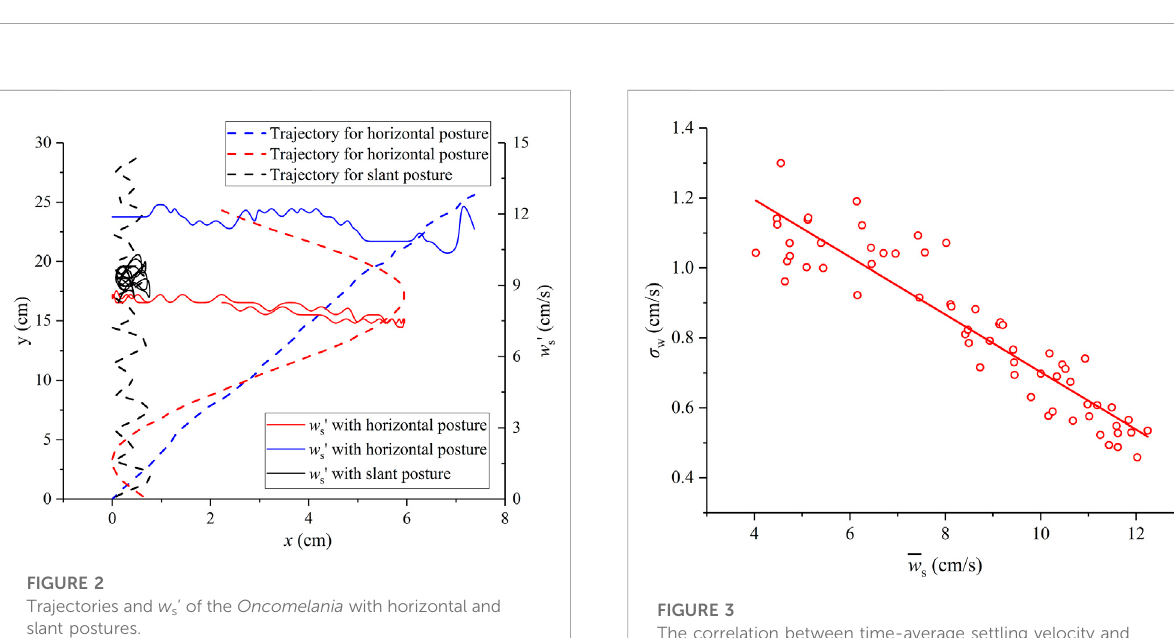
FIGURE 1 Schematic diagram of the experimental set-up and settling trajectory of the Oncomelania .